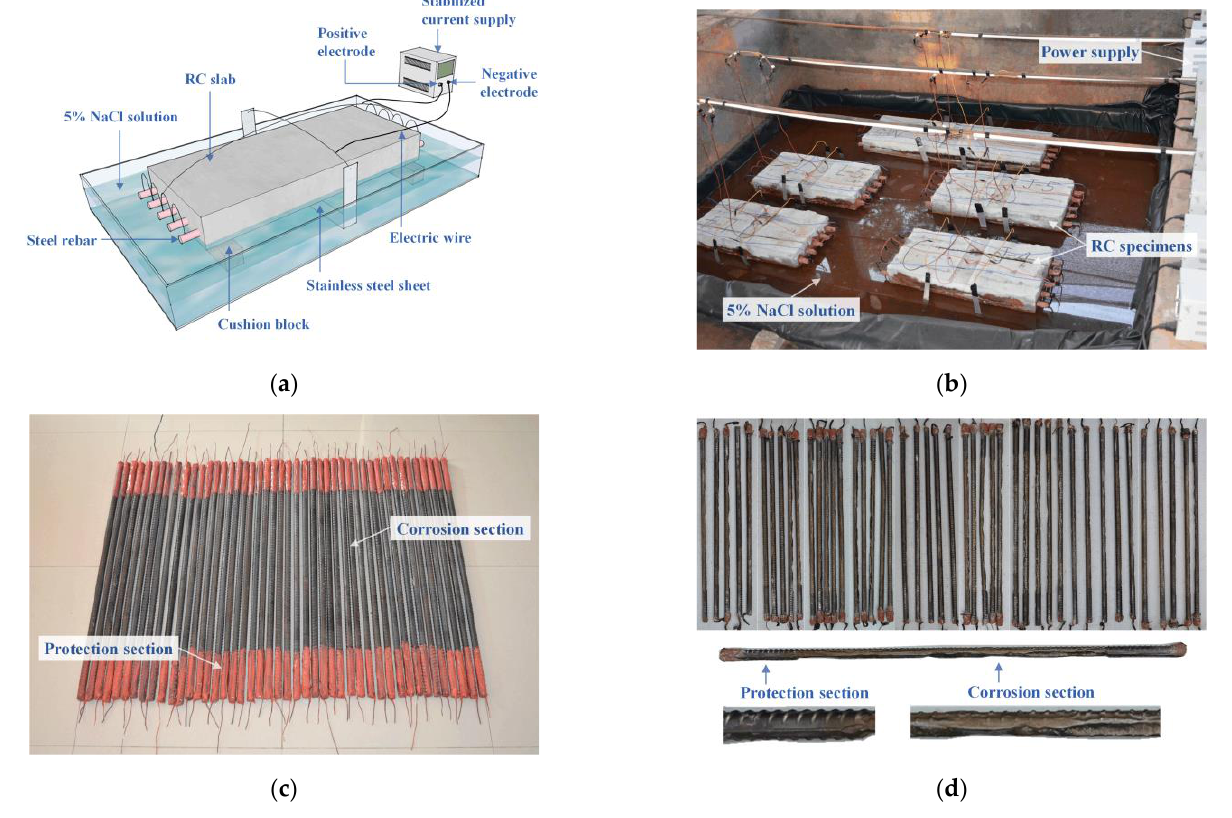
Figure 2. Accelerated corrosion set-up and specimens: ( a ) schematic illustration of accelerated cor- rosion set-up; ( b ) test instrumentation of half-immersed slabs; ( c ) rebar specimens for accelerated corrosion; ( d ) corroded rebars after rust cleaning.